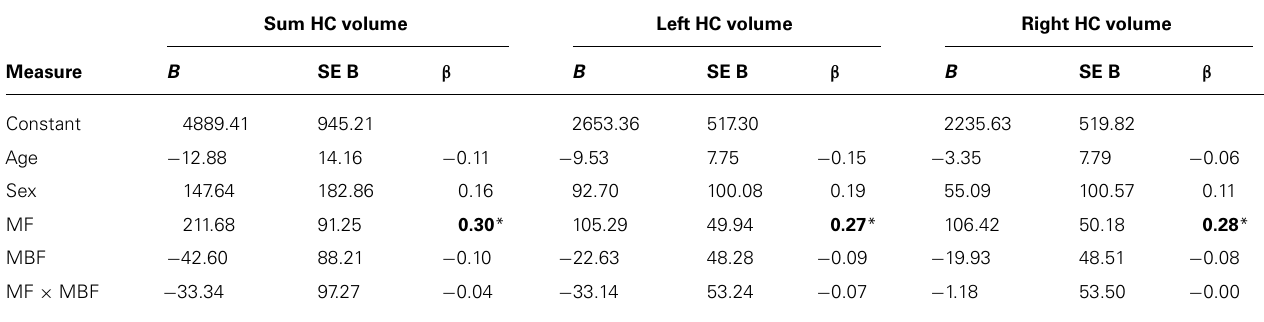
Table 2 | Regression statistics for hippocampal (HC) volume (sum HC volume: sum of left and right volume, left HC volume, right HC volume) as dependent variable and age, sex, motor fitness (MF), metabolic fitness (MBF), and their interaction term as independent